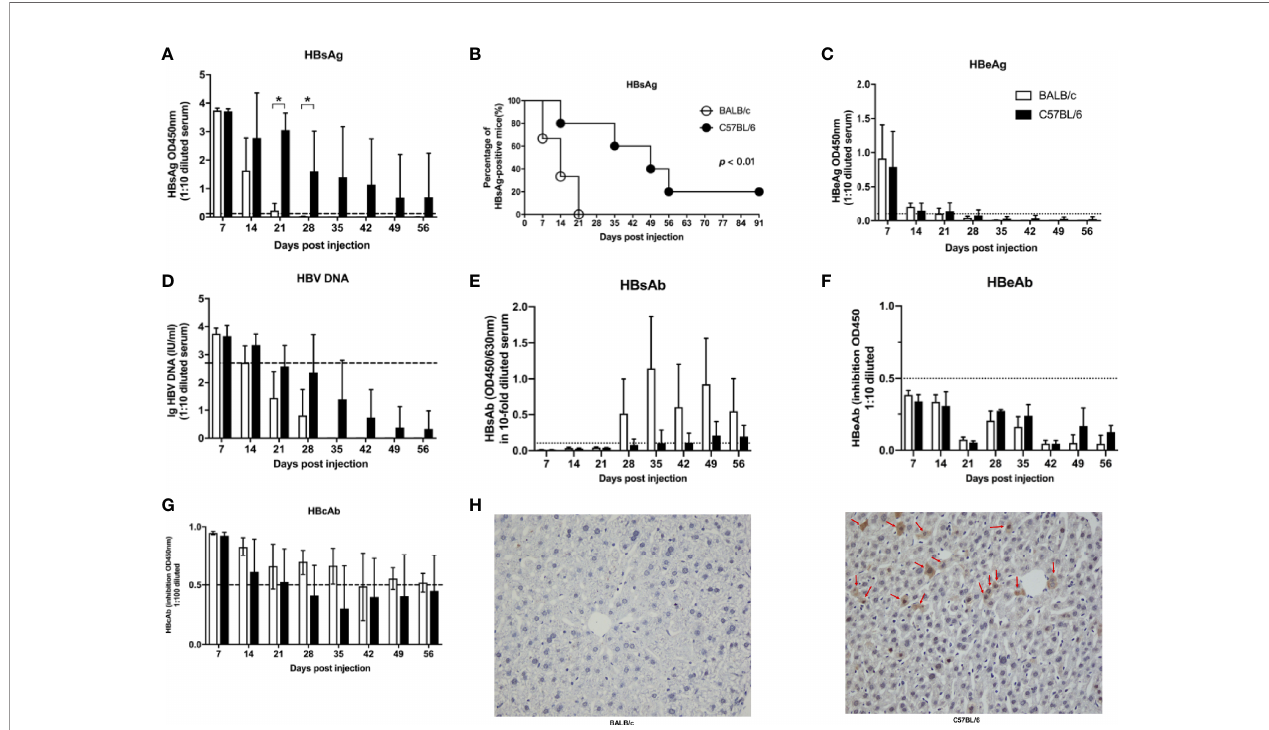
FIGURE 1 | Host gene background determined the outcomes of HBV infection in mice. BALB/c and C57B/6 mice were hydrodynamically injected with pAAV/ HBV1.2. The levels of HBsAg (A) , HBeAg (C) , HBV DNA (D) , HBsAb (E) , HBeAb (F) , HBcAb (G) in sera were measured at the indicated times. The cutoff values are indicated by dotted lines. (B) Kaplan – Meier curve showing the percentage of HBsAg-positive mice. (H) Mice were euthanized at 56 dpi, and the expression of HBcAg in the liver was measured by IHC. The HBcAg positive hepatocytes was labeled with red arrows. n=10/group, * P <